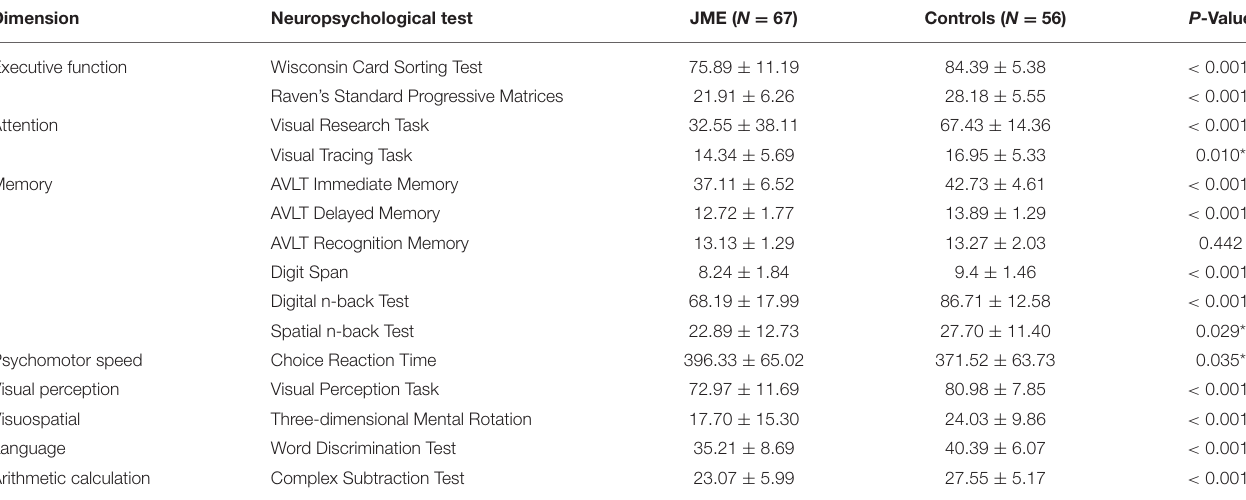
TABLE 5 | Comparison of scores on neuropsychological test between two groups (Mean ± SD).